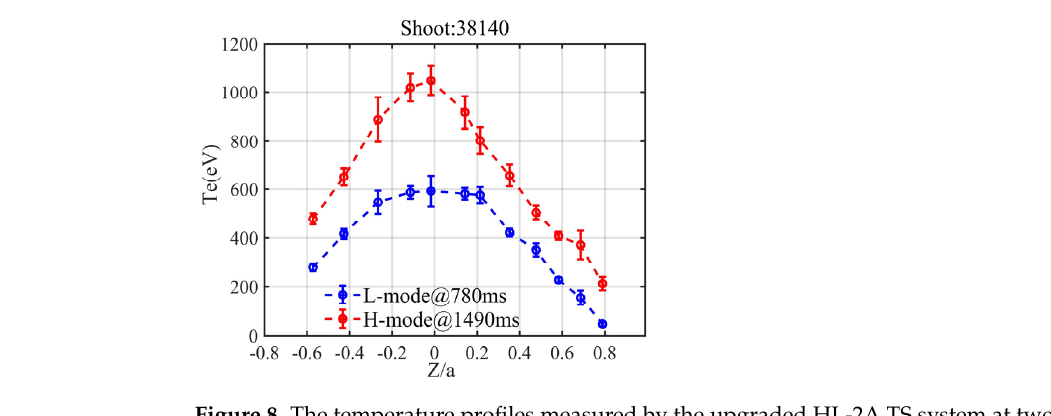
Figure 8. The temperature profiles measured by the upgraded HL-2A TS system at two moments of the L-mode and H-mode, respectively. Z is the height to the midplane of the measurement point, and a = 400 mm is the minor radius.